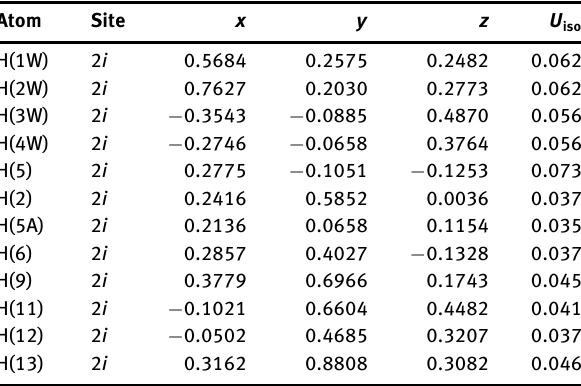
Table 2: Fractional atomic coordinates and isotropic or equivalent isotropic displacement parameters (Å 2